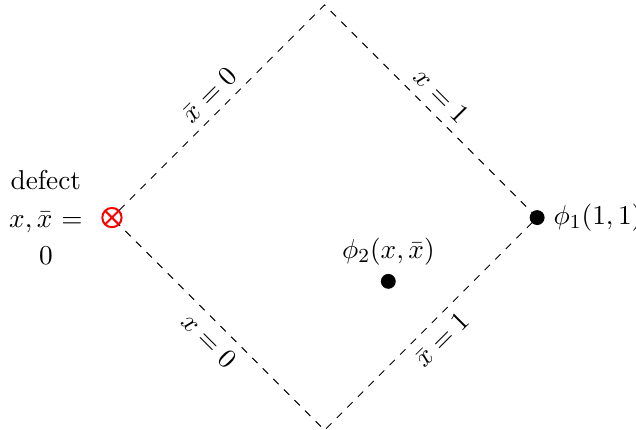
Figure 1. Two-point function con(cid:12)guration in a plane orthogonal to the defect. The (cid:13)at defect is at the origin while the operators (cid:30) 1 and (cid:30) 2 are at points (1 ; 1) and ( x; (cid:22) x ), respectively.